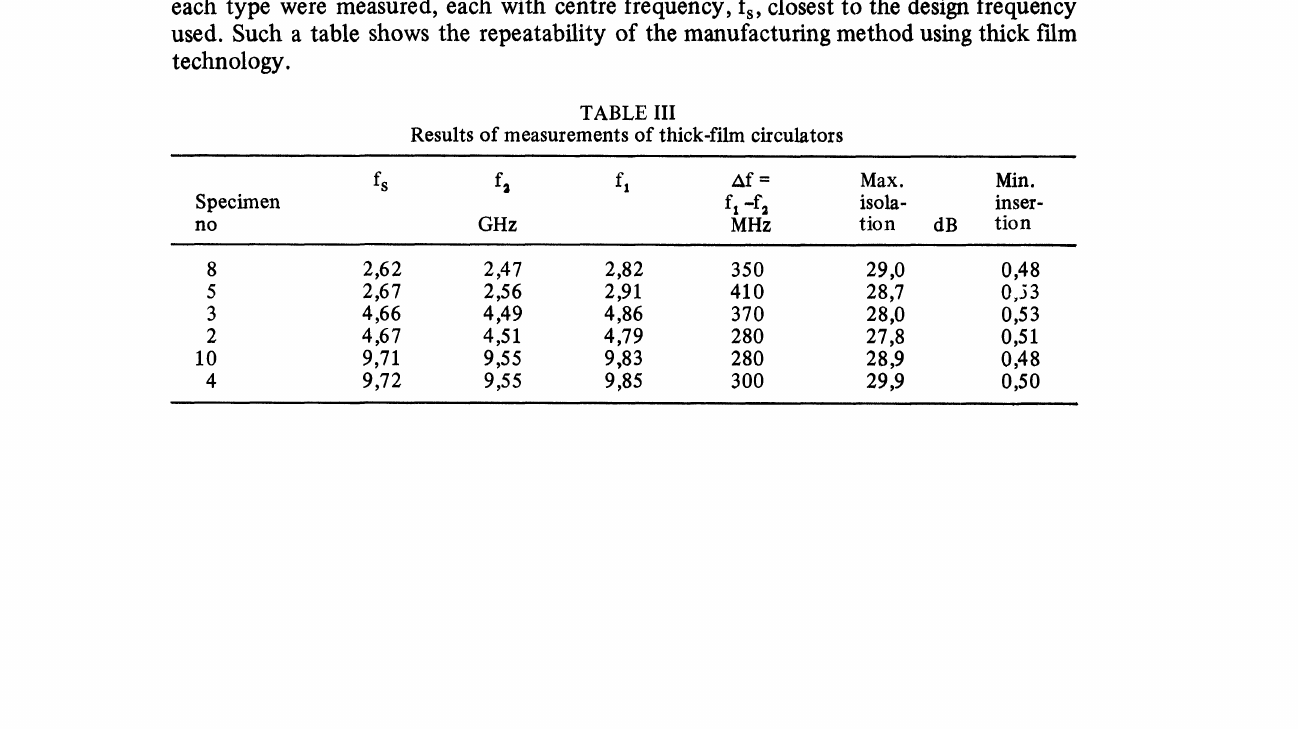
TABLE III Results of measurements of thick-film